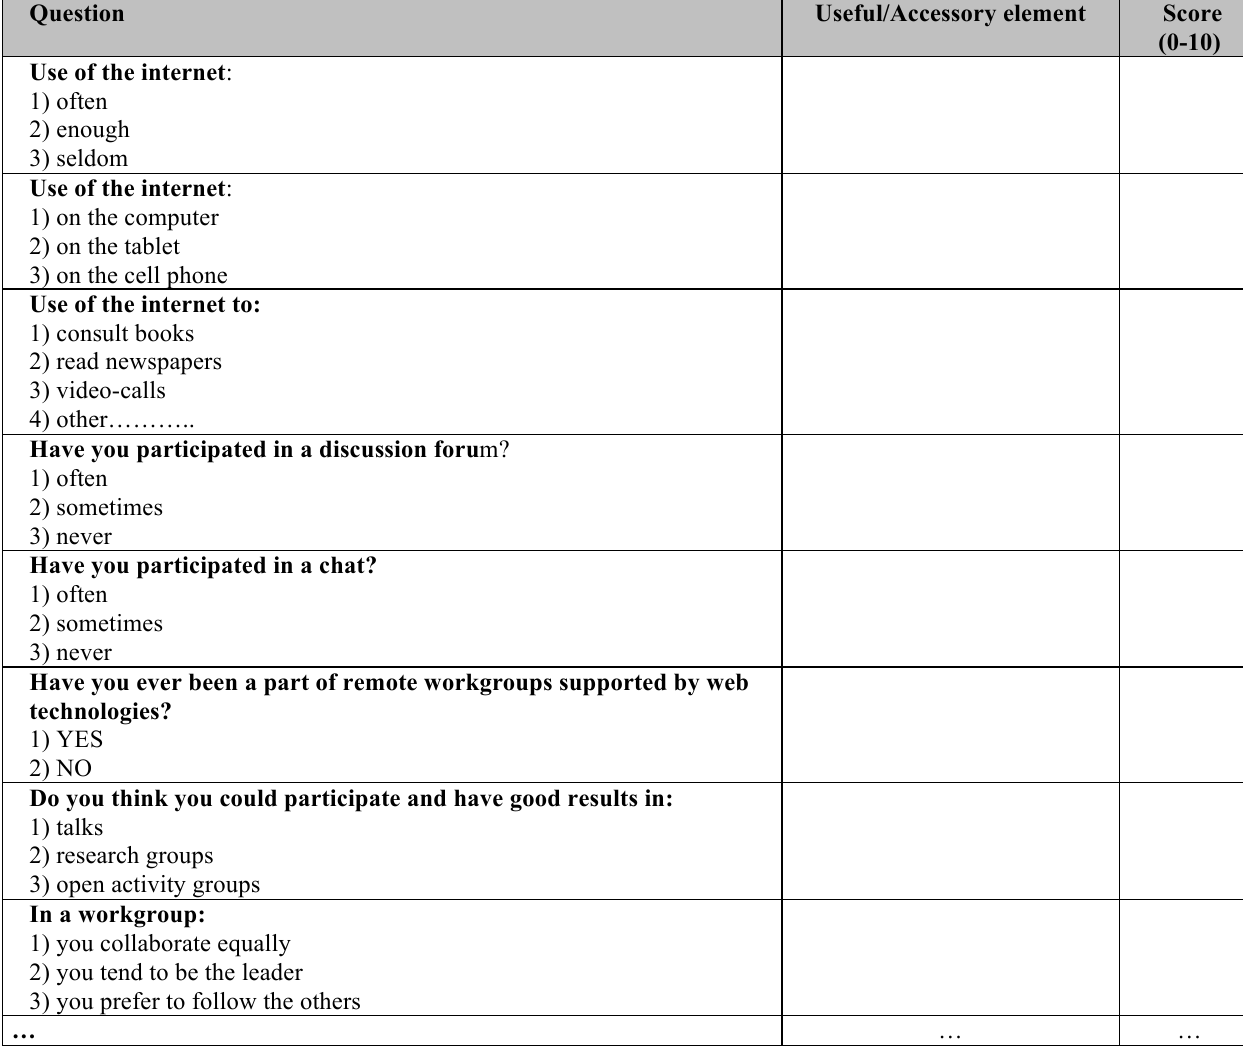
Table 1. Excerpt from the ex-ante